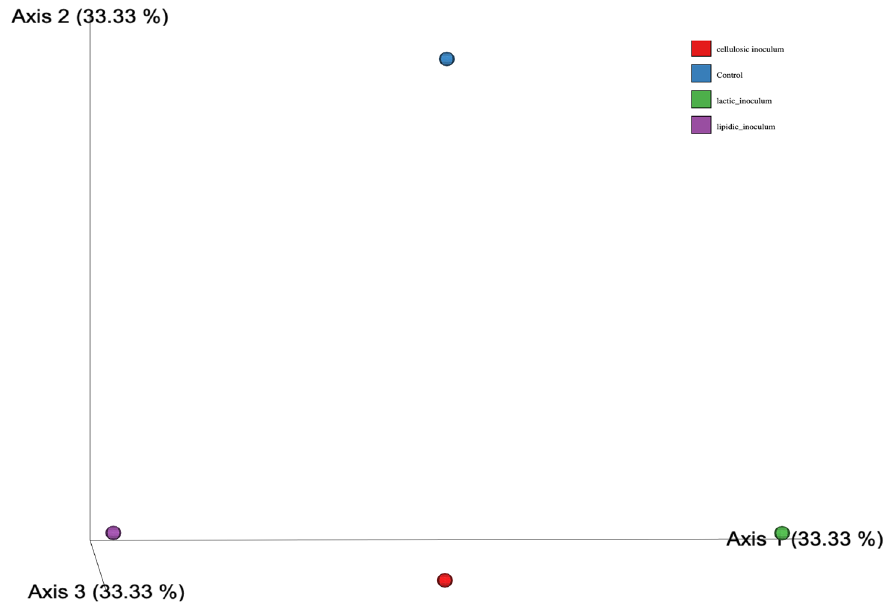
Figure 6. Principal coordinate analysis (PCoA) of beta diversity of bacterial communities from CM substrate (control) and three best inocula (cellulosic C.I1; lipidic Li.I; and lactic La.I1). Analyses were performed by using the Jaccard distance matrix and visualized with Emperor.